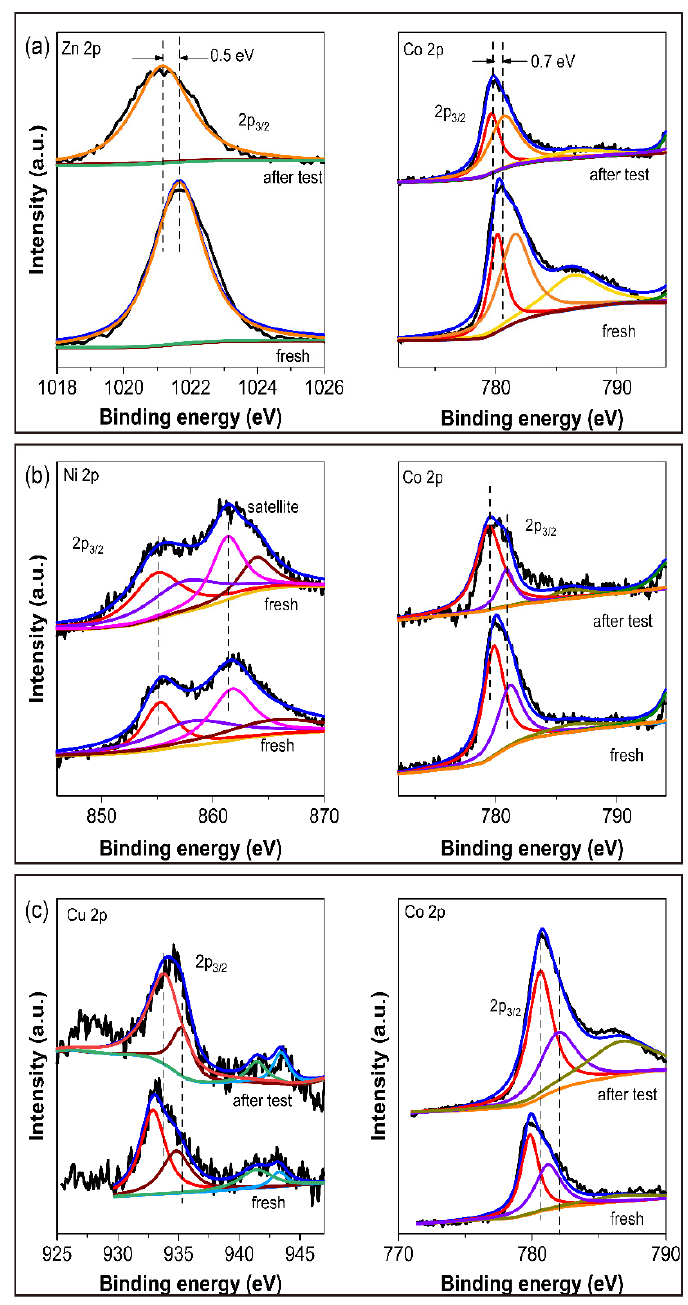
Figure 6. XPS spectra of spinels (cf. both before and after the reaction): ( a ) Zn and Co 2p spectra of Zn spinel; ( b ) Ni 2p and Co 2p spectra of Ni spinel; ( c ) Cu 2p and Co 2p spectra of Cu spinel.